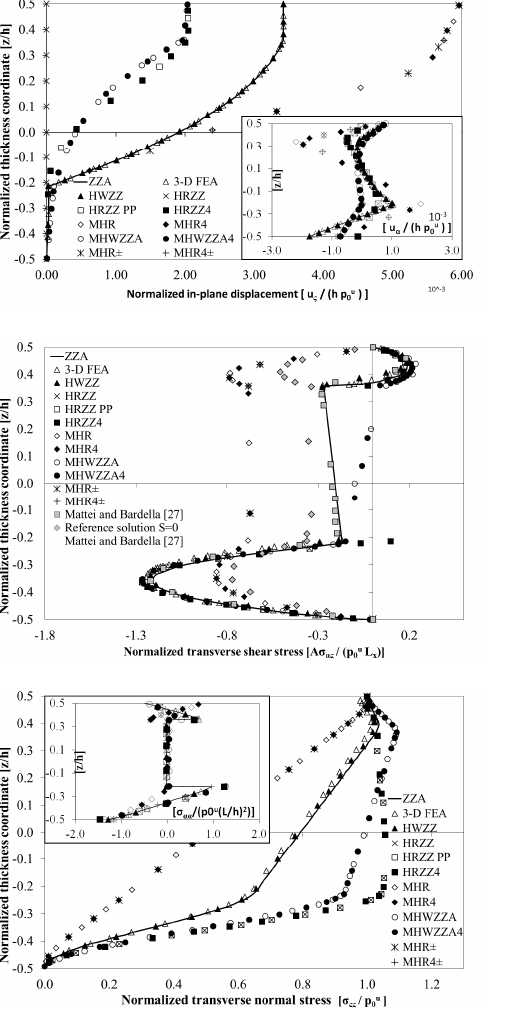
Figure 1. Case a1: Propped cantilever sandwich plate in cylindrical bending ( L x / h = 5.714) under a uniform loading on the top layer.